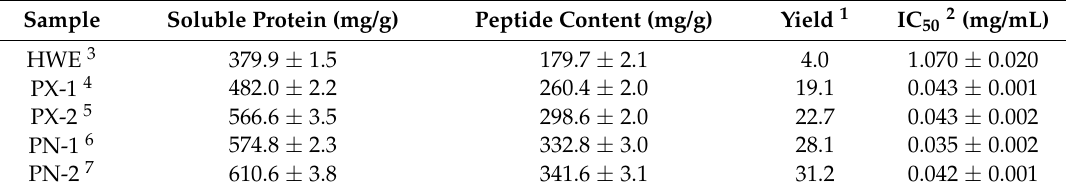
Table 1. Effect of treatment on soluble protein and peptide content, yield, and angiotensin I-converting enzyme (ACE) IC 50 of C. sorokiniana protein